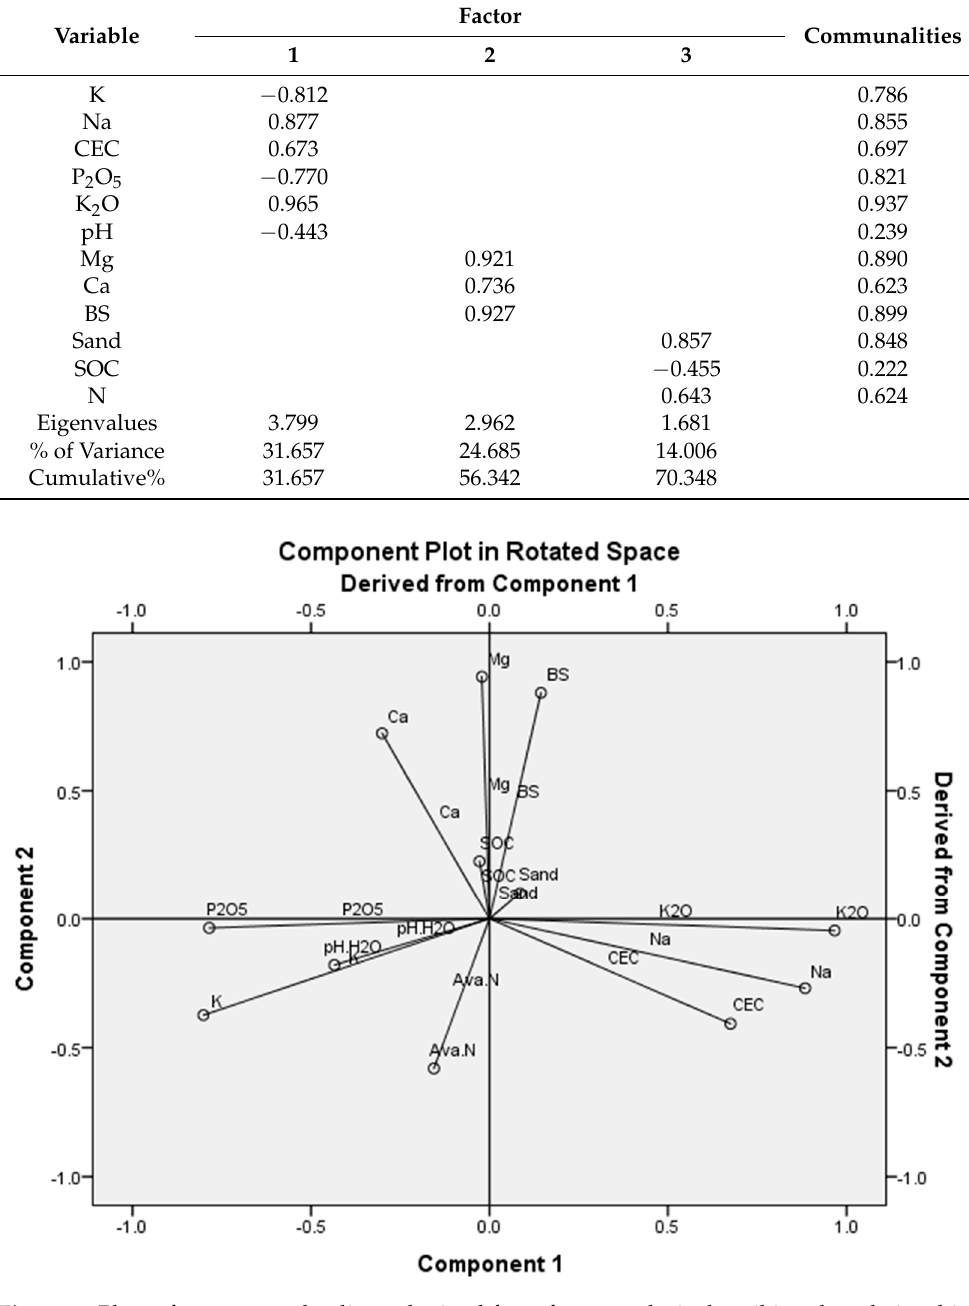
Figure 2. Plots of component loadings obtained from factor analysis describing the relationships among soil properties. among soil